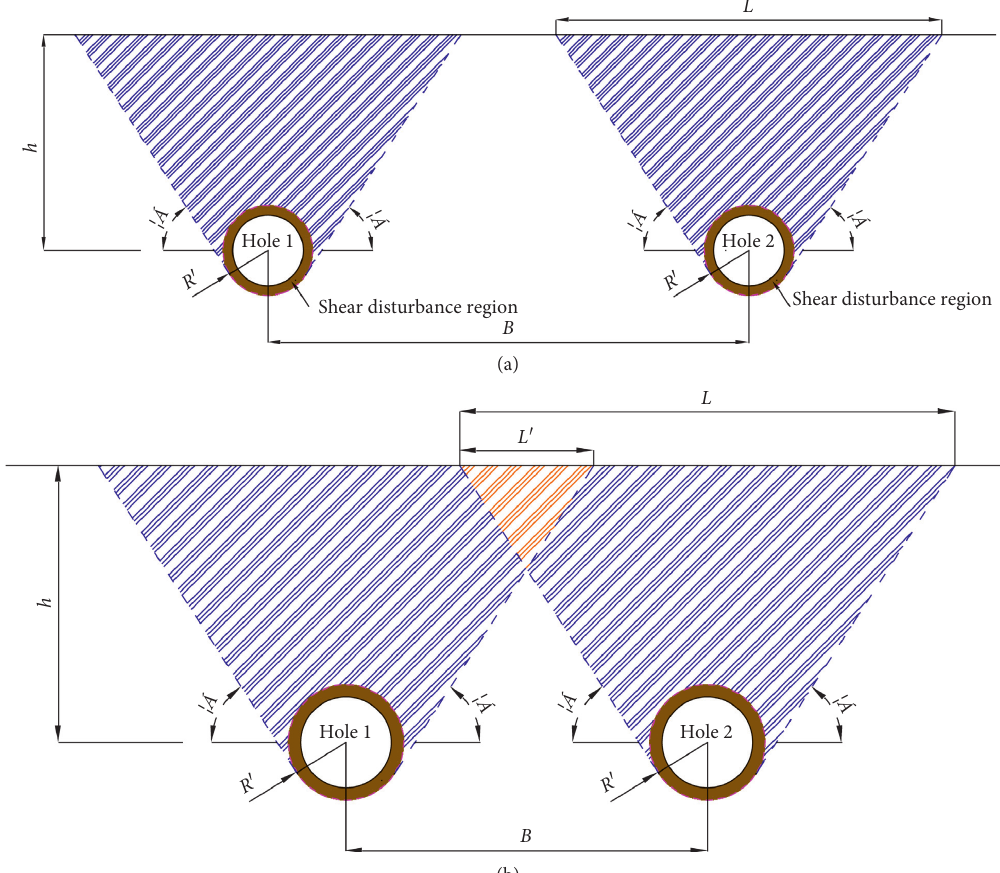
Figure 3: Schematic diagram of lateral disturbance range of double-hole jacking. (a) The center spacing is large in double-hole excavation. (b) The center spacing is small in double-hole